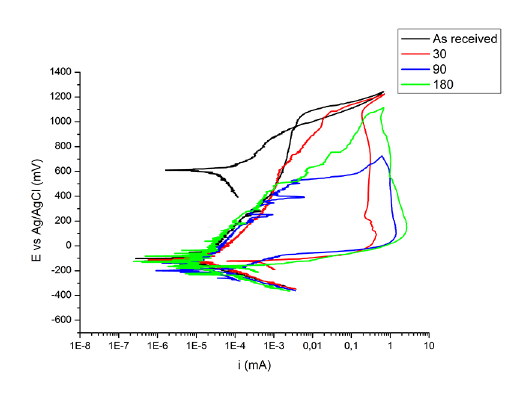
Figure 9. Potentiodynamic polarization curves specimens after as-received, 30, 90 and 180 minutes ageing at 830 ºC.